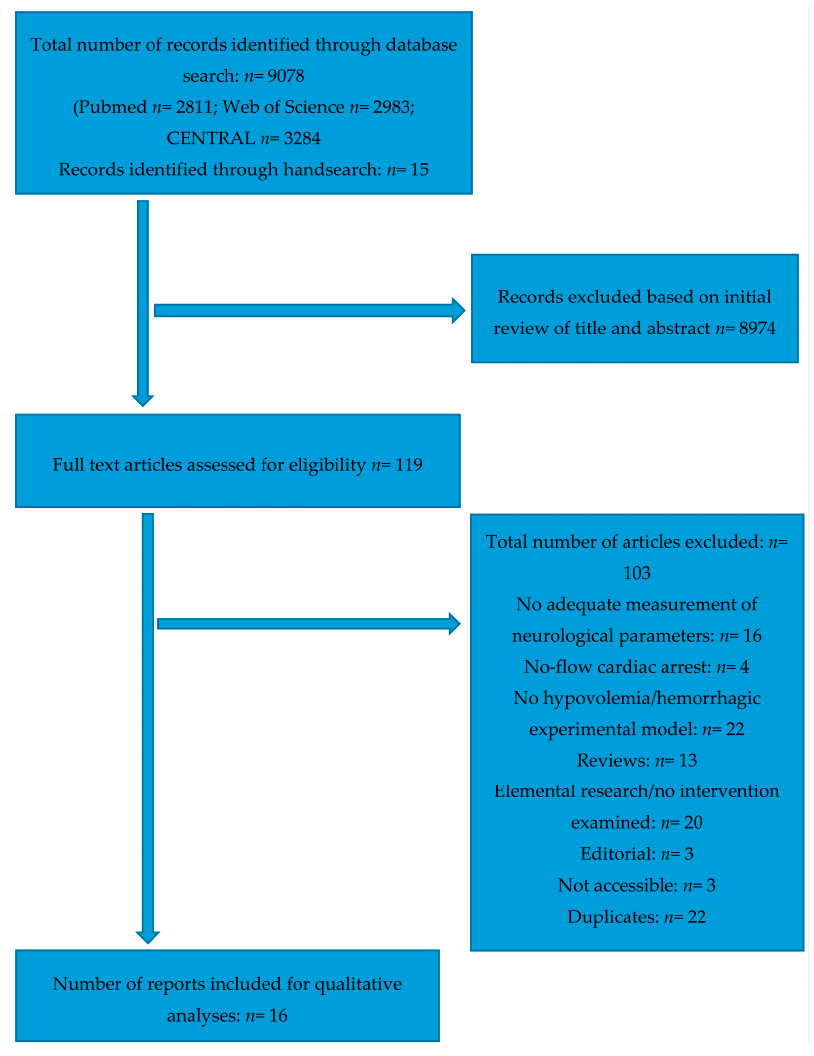
Figure 1. PRISMA (Preferred Reporting Items for Systematic Reviews and Meta-Analyses) flow